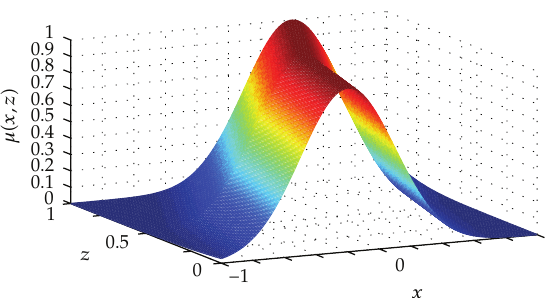
Figure 1: A three-dimensional fuzzy